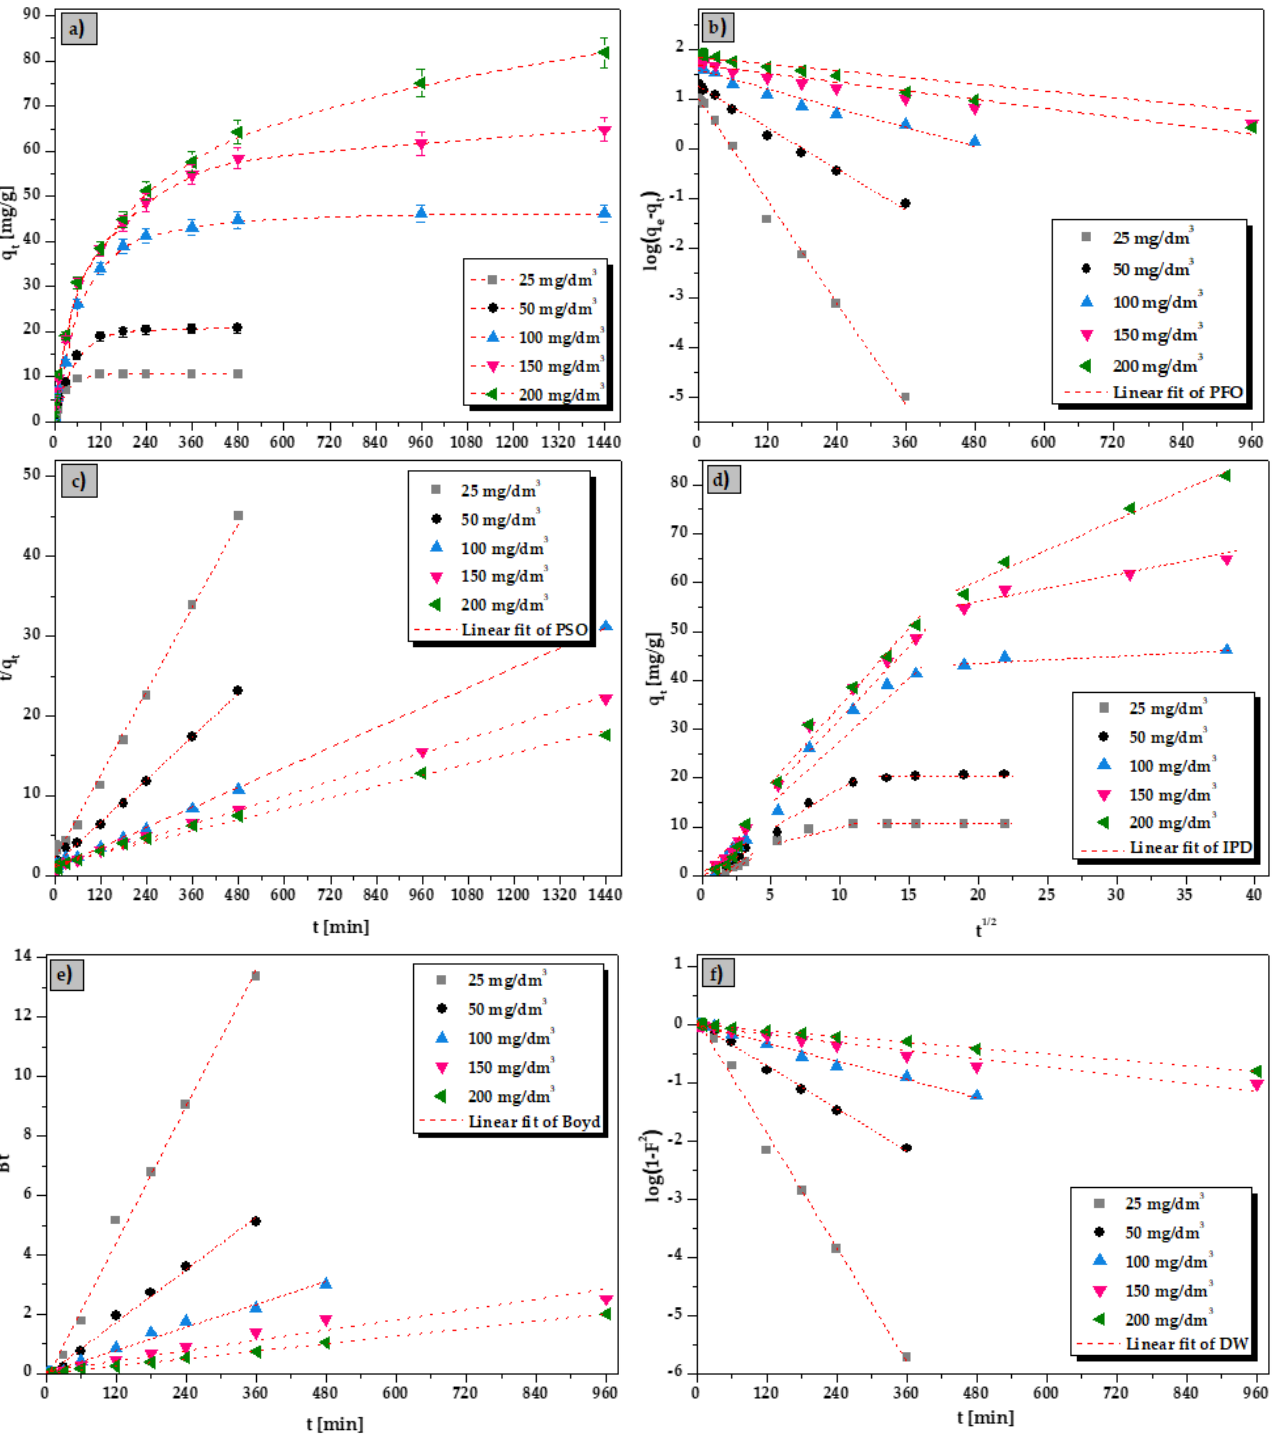
Figure 6. ( a ) Influence of interaction time and linear fitting of the kinetic models: ( b ) PFO, ( c ) PSO, ( d ) IPD, ( e ) Boyd, and ( f ) DW for the La(III) ions sorption on the ALG 5 L 1 composite (conditions: C 0 = 25–200 mg/dm 3 , pH = 5, V = 20 cm 3 , m = 0.05 g, t = 1–1440 min, T = 293 K). The sorption process kinetics of La(III), Ce(III), Pr(III) and Nd(III) ions was also de- termined for raw lignin (Figure S7 and Table S7). The sorption equilibrium state was achieved after 120 min. The kinetic parameters of the above metal ions on raw lignin were